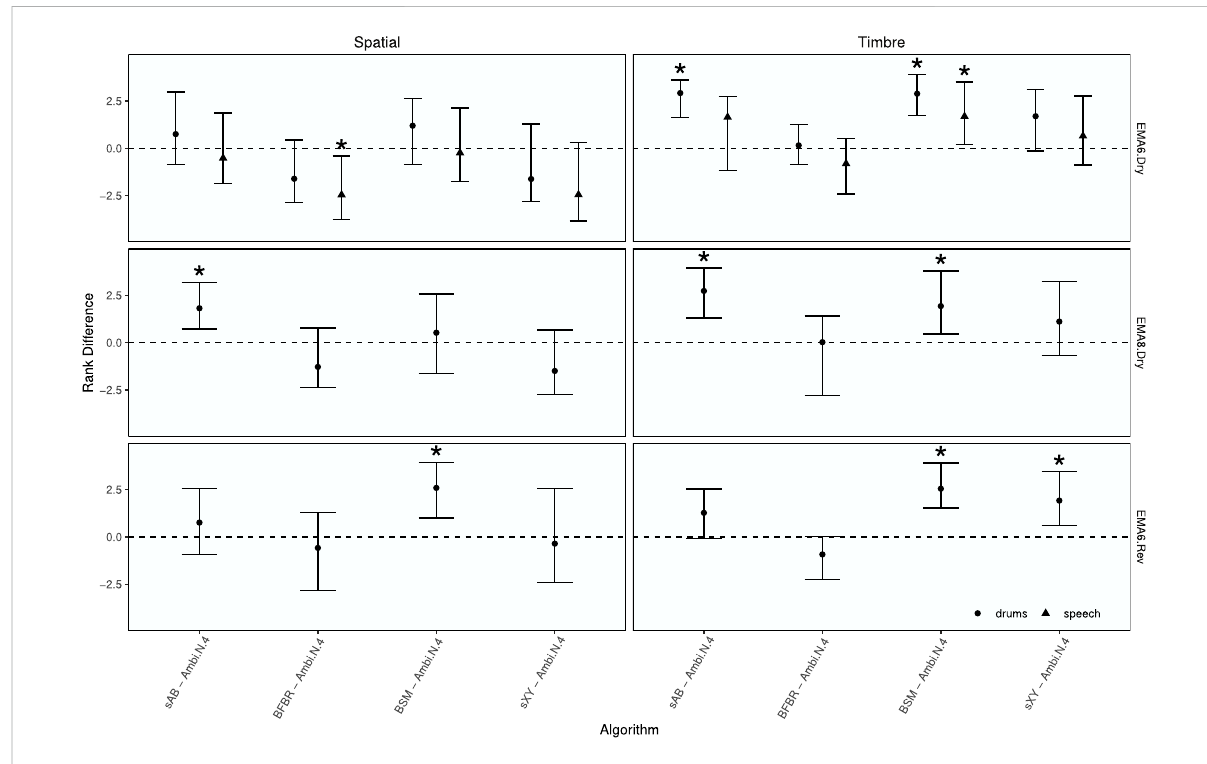
FIGURE 14 EXPERIMENT 1: Median rank differences between renderings and Ambisonics N =4 by attribute, room, array con fi guration, and test signal. Points represent median rank difference and error bars depict the 89% highest density credible interval. Asterisks indicate statistically signi fi cant differences.